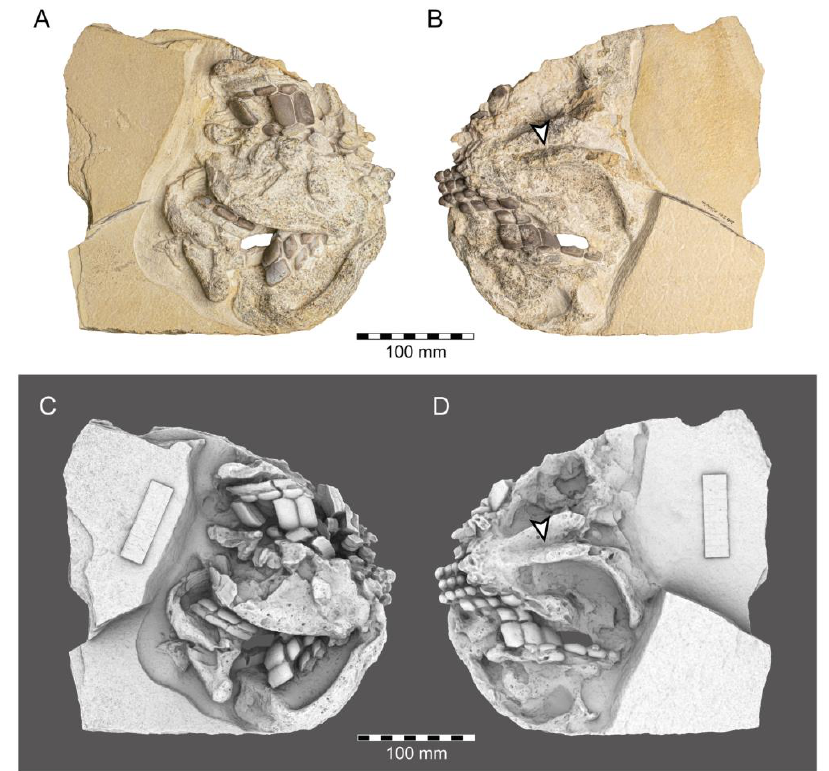
Figure 12. Jaws and associated teeth of † Strophodus sp. from the early Tithonian of Mörnsheim. ( A , B ) Complete specimen (SNSB-BSPG 2010 I 91). ( C , D ) ambient occlusion photogrammetric model (arrows point to symphysis connecting palatoquadrates; photogrammetric model courtesy of Christoph Kettler).